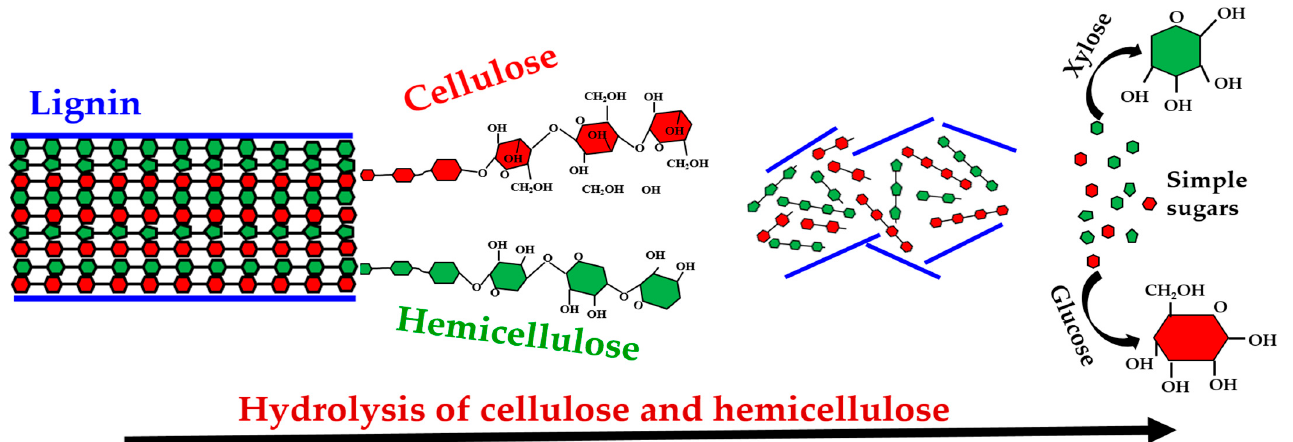
Figure 3. Schematic representation of the hydrolysis of cellulose and